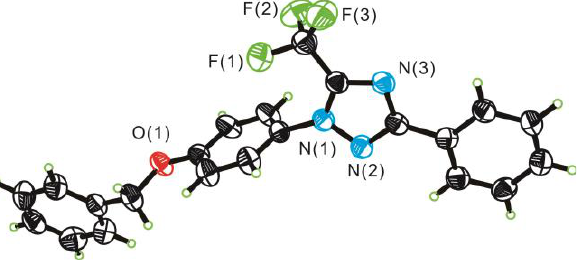
Figure 3. ORTEP diagram of 3s with thermal ellipsoids at the 40% probability level.